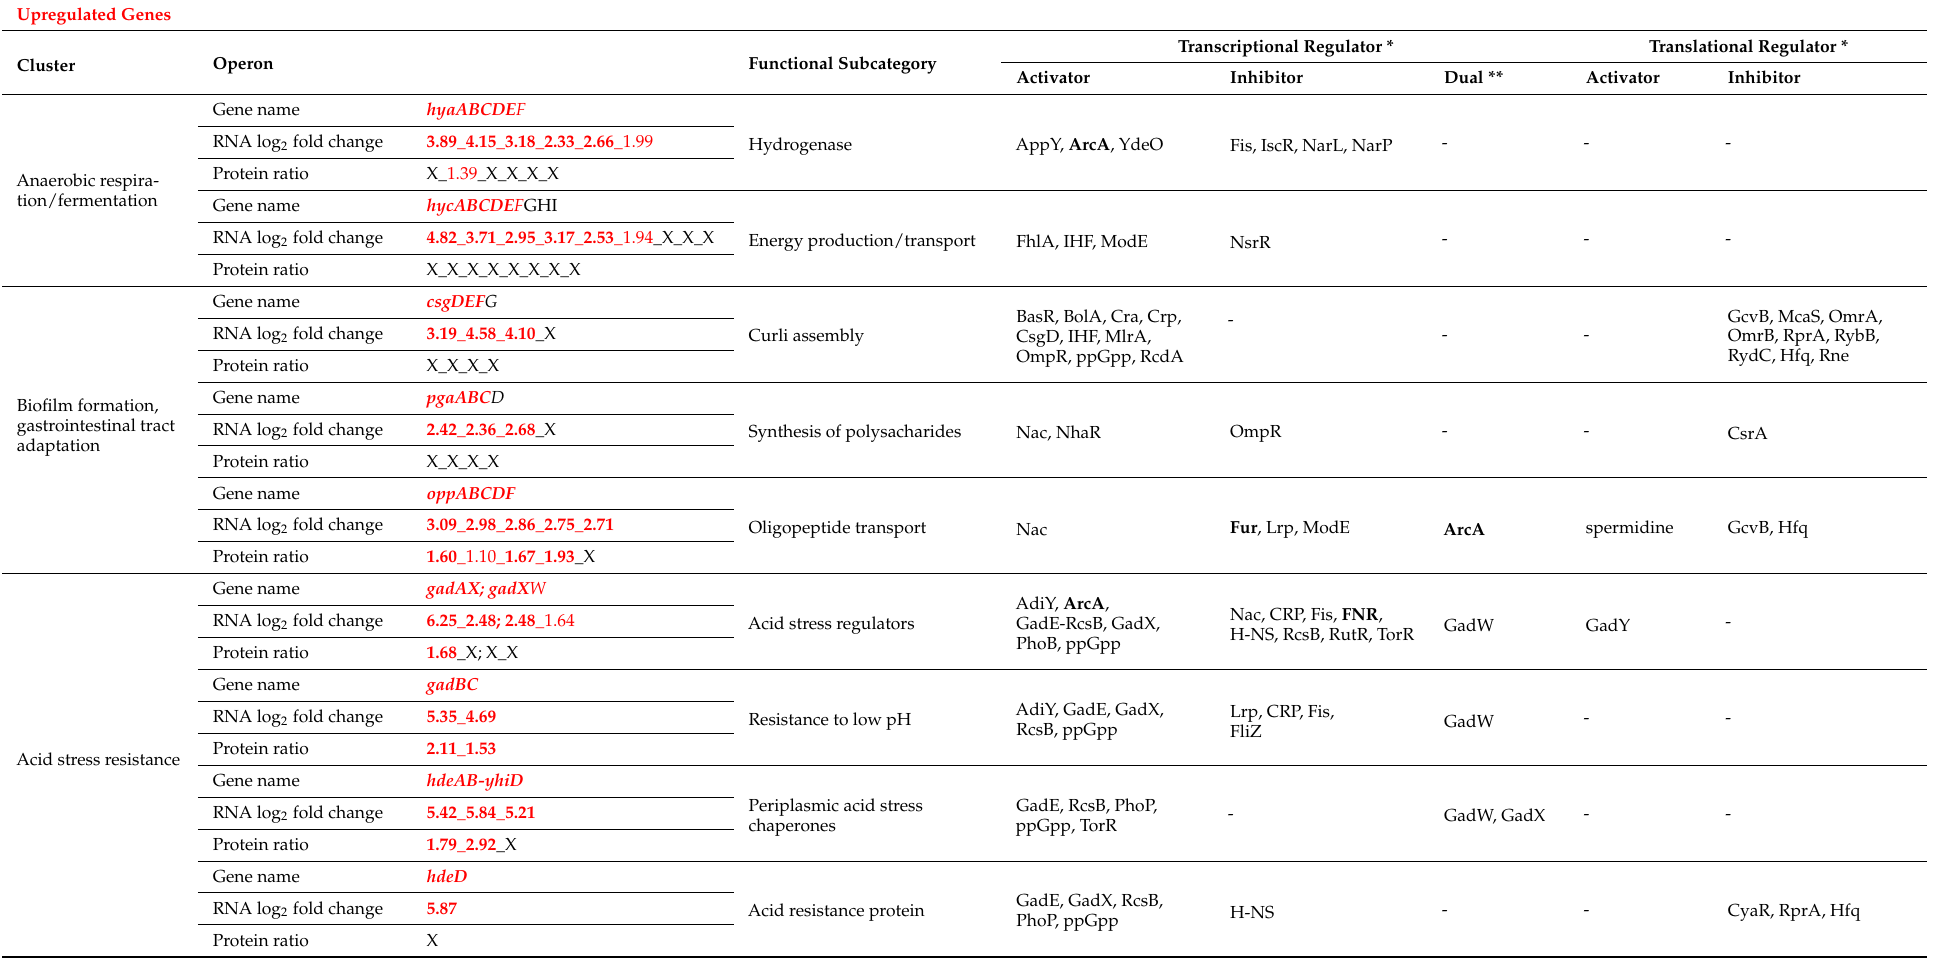
Table 1. Classification of the main gene clusters differentially expressed under microaerobic versus aerobic